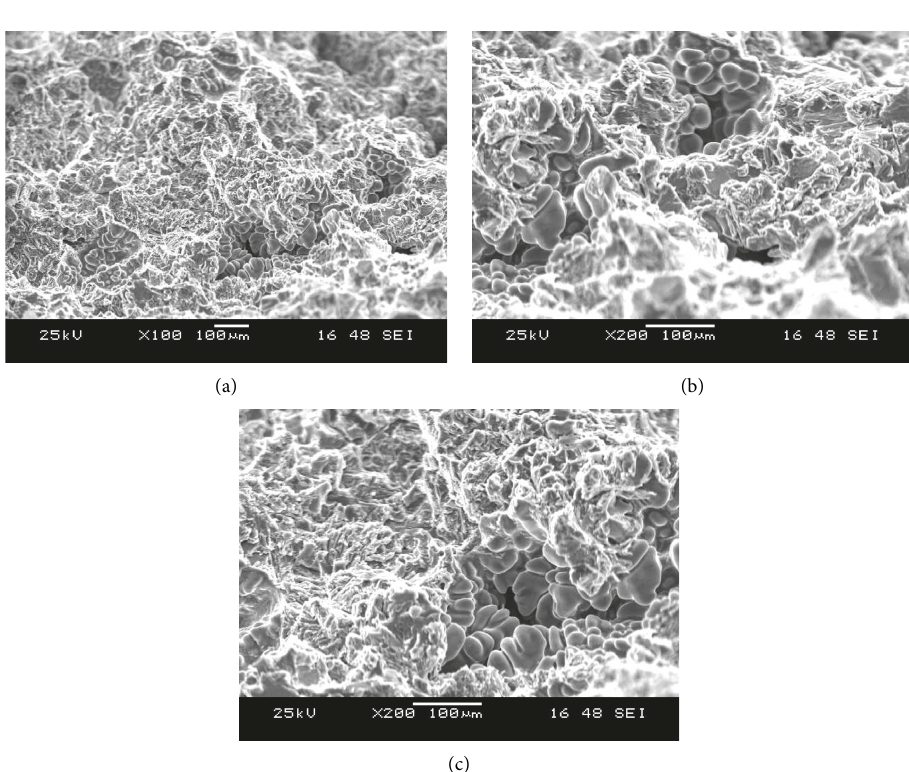
Figure 10: (a–c) FESEM of alloy and composites. (a) Al 6061 alloy; (b) 3% (AlN+ SiC) with Al 6061 alloy; (c) 6% (AlN +SiC) with the Al 6061 alloy.